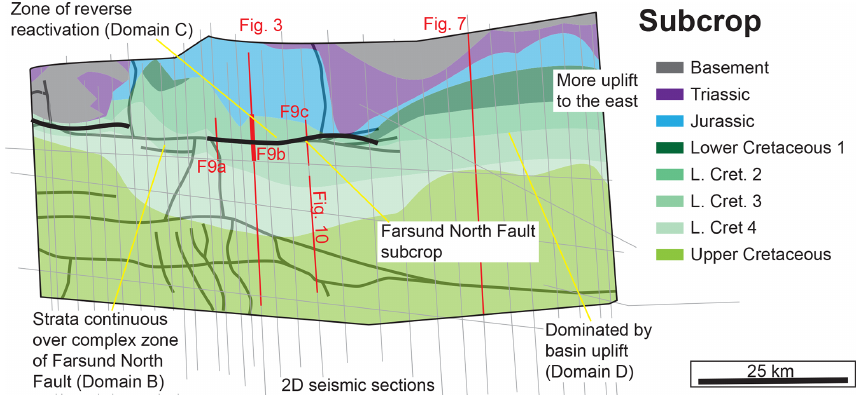
Figure 8. Subcrop map across the Farsund Basin at the base Pleistocene unconformity. Black lines show the locations of faults that are truncated by the base Pleistocene unconformity; thick grey lines show fault geometries at the acoustic basement level. Thin grey lines show the location of 2D seismic sections used to create the map, with those referred to elsewhere in the study in